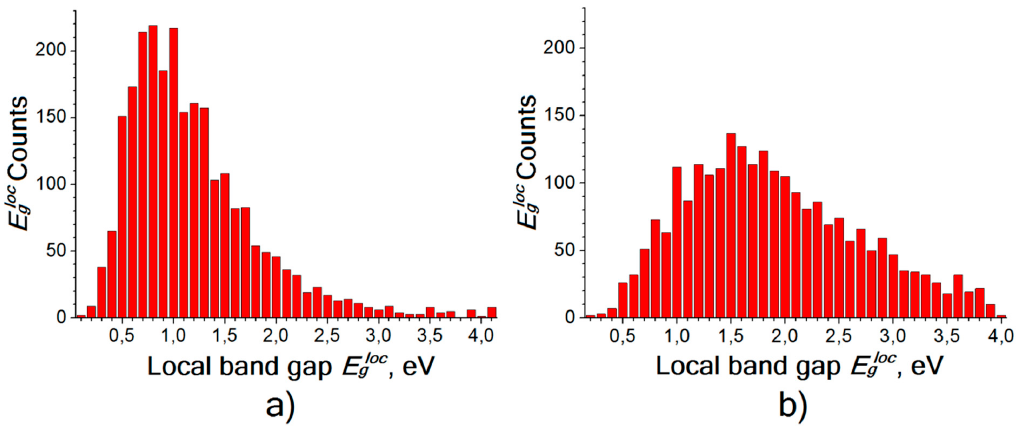
Figure 3. Map of the oxide phase distribution over the titanium coating surface. Different colors indicate areas with different local band gap values E gloc : ( a ), oxidation in air ( t = 720 h, T = 300 K); ( b ) oxidation during annealing ( t = 13 h, T = 770 K). Figure 4. Histograms of the frequency distribution of E gloc values: ( a ), oxidation in air ( t = 720 h, T = 300 K); ( b ), oxidation during annealing ( t = 13 h, T = 770 K). Table 1. Results of E g measurements for various oxidation conditions. T is the annealing temperature, t is the annealing duration of the sample in oxygen, E g is the most probable band gap energy under the selected oxidation conditions.